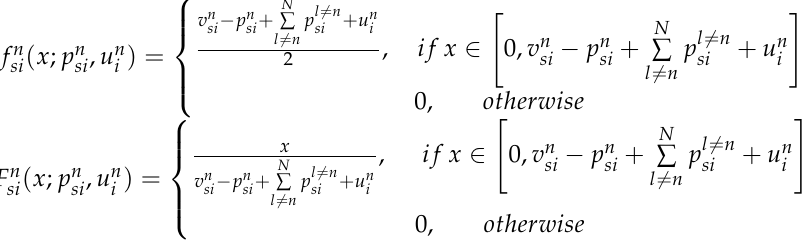
1.1 0.9 H L v v   ; si si